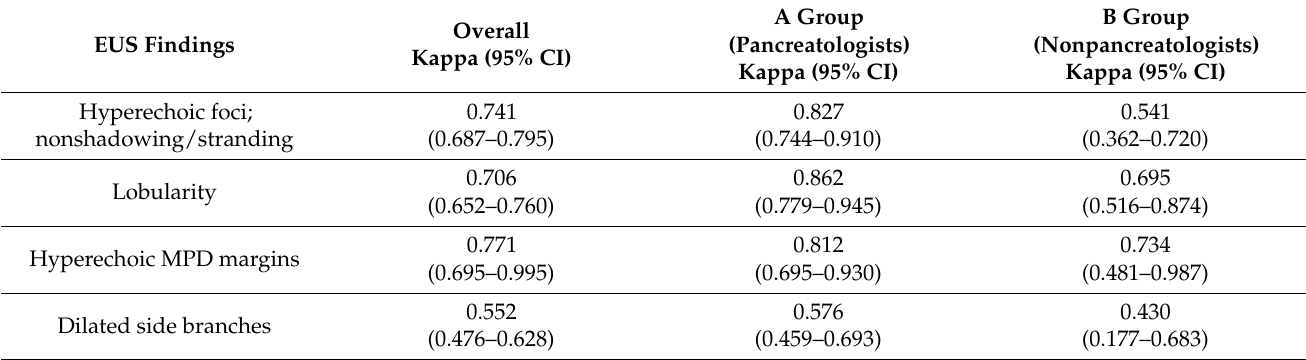
Table 3. Interobserver reliability of each EUS finding in